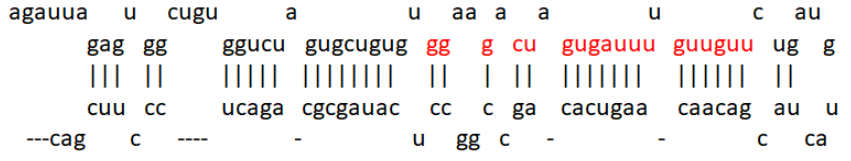
Figure 2. miR-7 sequence. Representation of the microRNA-7 sequence obtained from miRDB (http://mirdb.org/cgi-bin/mature_mir.cgi?name=hsa-miR-7-5p accessed on 1 June 2022). The seed region is highlighted in red.